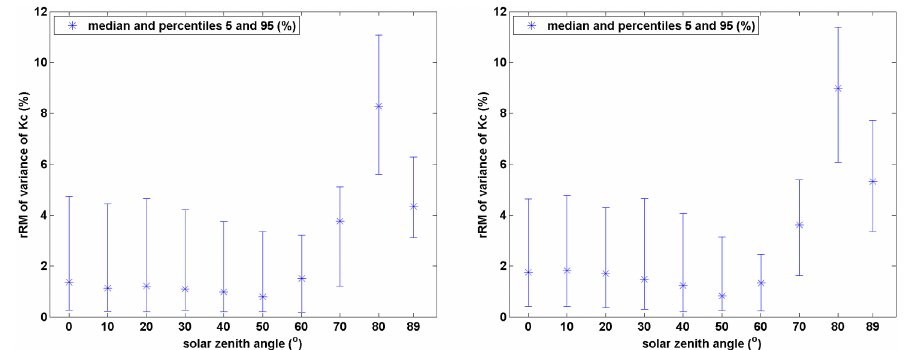
Figure 4. Median (star) and 5th and 95th percentiles of RM (v(K c )) relative to the corresponding mean K c for all couples ( ρ g , τ c ) as a function of θ S for water cloud (left) and ice cloud (right).